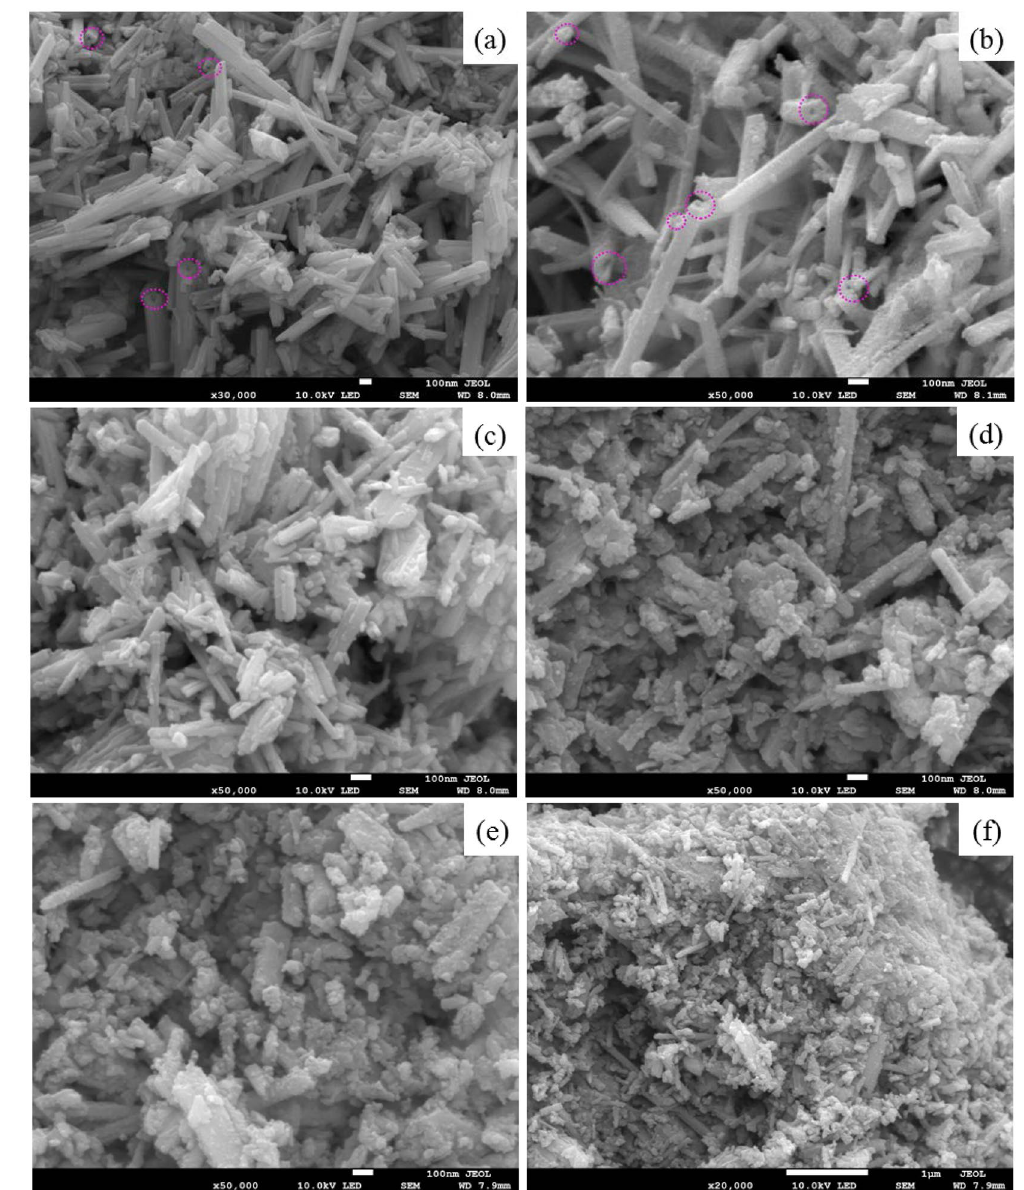
Figure 6. SEM image of ( a ) T-Ag/MnO 2 , ( b ) T-Ag/MnO 2 with aluminum sol, ( c ) R-Ag/MnO 2 , ( d ) R-Ag/MnO 2 with aluminum sol, ( e , f ) R CB -Ag/MnO 2 with aluminum